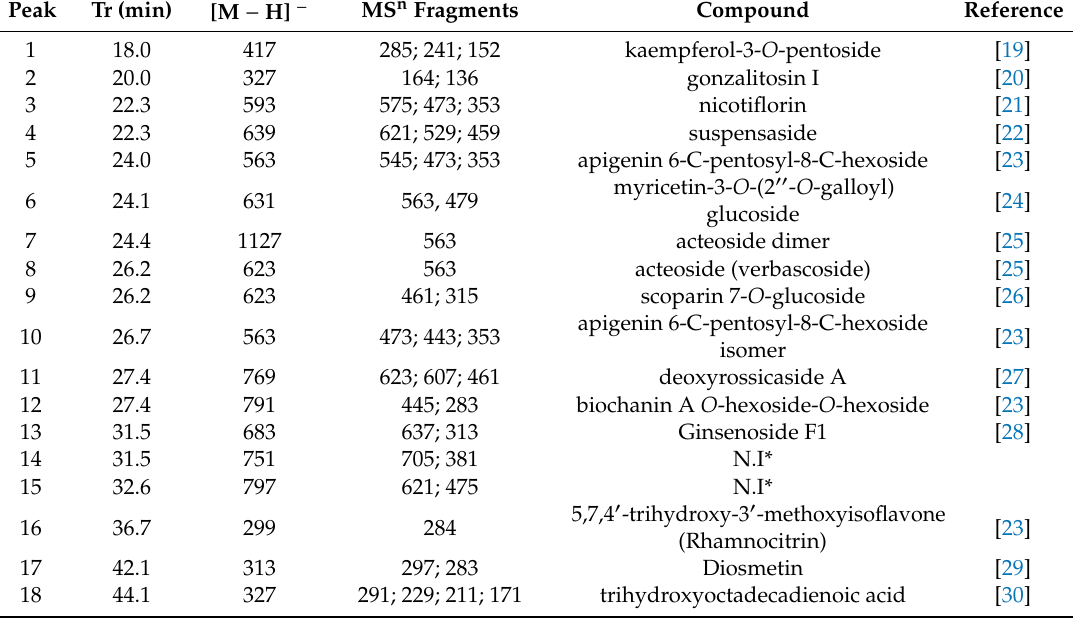
Figure 7. Total Ion Chromatogram of extract from S. dulcis acquired by LC-ESI-MS ( m / z : 100–1500 Da). Table 1. Identification of compounds in S. dulcis crude extract by LC-ESI/MS.